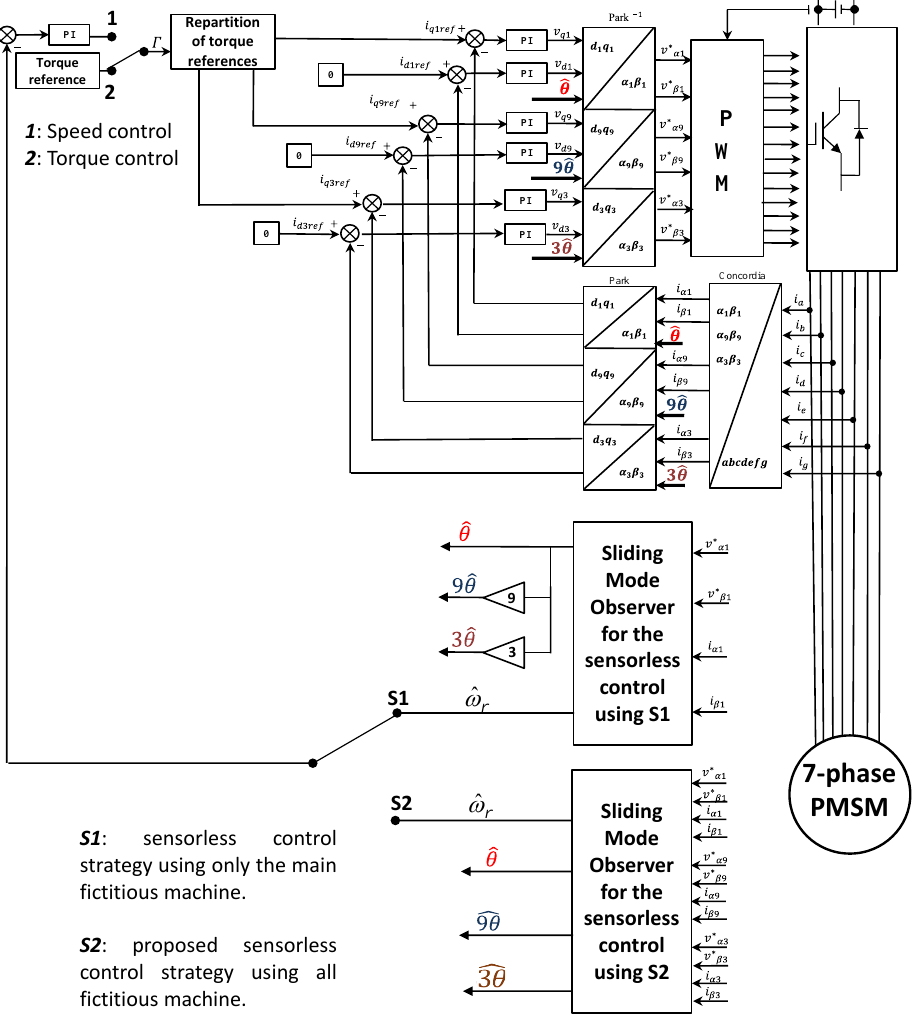
Figure 6. Block diagram of two sensorless control strategies S1 and S2 for the non-sinusoidal seven-phase PMSMs.